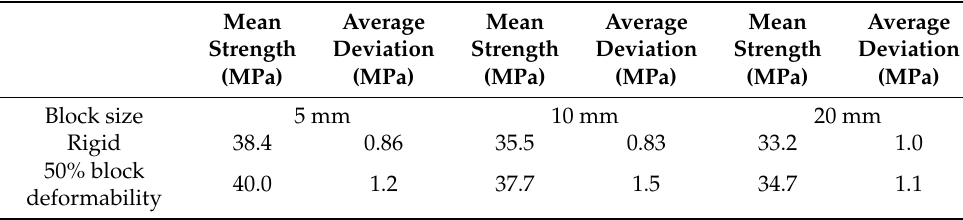
Table 4. Compressive strength of specimen for 3 Voronoi block sizes.